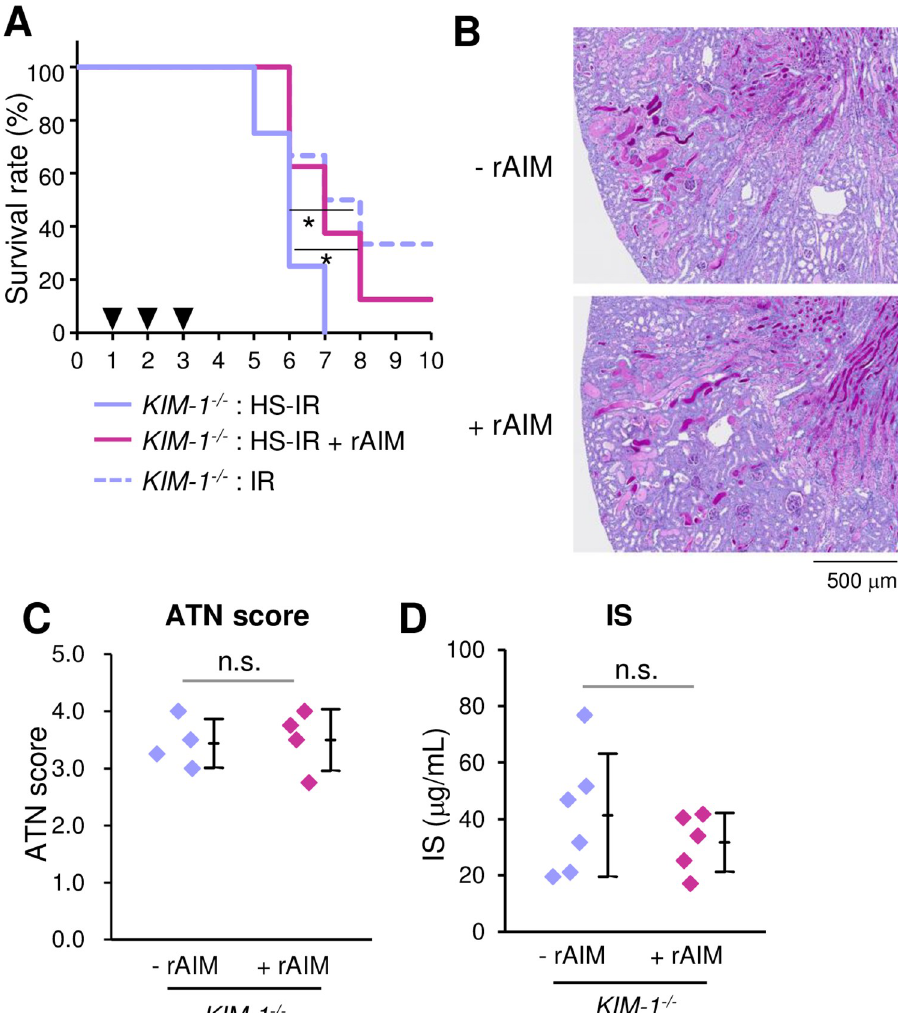
Fig 4. Involvement of the AIM-KIM-1 axis in the repair process of lethal AKI. (A) Kaplan-Meier survival curves . Wild-type and HS-IR KIM-1 −/− mice with or without rAIM injection (200 μ g). n = 8 for KIM-1 −/− mice; and n = 8 for rAIM-injected KIM-1 −/− mice. IR without HS ( n = 6) is also presented. Arrowheads indicate the times of rAIM injection. Statistics: log-rank test. (B) Representative photomicrographs of PAS-stained kidney specimens . The kidney images including the corticomedullary junction area from wild-type ( KIM-1 +/+ ) mice and HS-IR KIM-1 −/− mice with or without rAIM injection on day 3 after IR ( n = 3 each) are presented. (C) ATN scores on day 3 after IR. n = 4 each. Statistics: Welch’s t-test. (D) Serum IS levels. Values on day 3 after HS-IR. n = 6 for KIM-1 −/− mice; and n = 5 for rAIM-injected KIM-1 −/− mice. IR without HS ( n = 6) are presented. Statistics: Welch’s